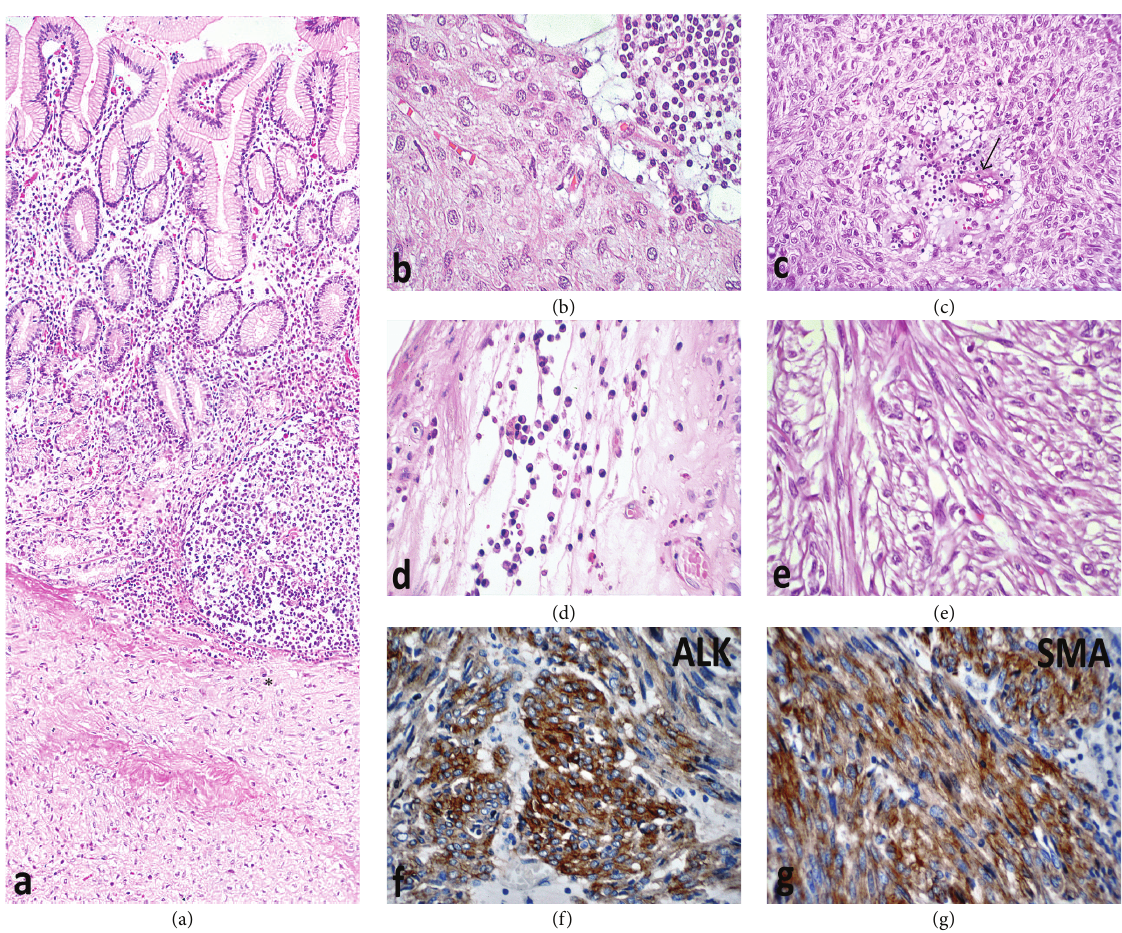
Figure 4: Microscopy of IMT. (a) A cellular tumor (asterisk) infiltrating into submucosa and mucosa of the stomach (hematoxylin and eosin stain H & E, × 50). (b) Alternating lymphoplasmacytic infiltration and tumor cells (H& E, × 200). (c) In some areas, scattered inflammatory cells and many vascular structures (arrow) are seen (H&E, × 100). (d) Plasma cells forming clusters in a myxoid background (H& E, × 100). (e) Spindle-shaped myofibroblastic tumor cells show a fascicular arrangement with relatively few inflammatory cells (H& E, × 400). (f) Strong cytoplasmic staining for anaplastic lymphoma kinase (ALK) in tumor cells (Anti-ALK antibody, counterstained with hematoxylin, × 200). (g) In some areas, tumor cells also express smooth muscle actin (SMA) (Anti-SMA antibody, counterstained with hematoxylin, ×